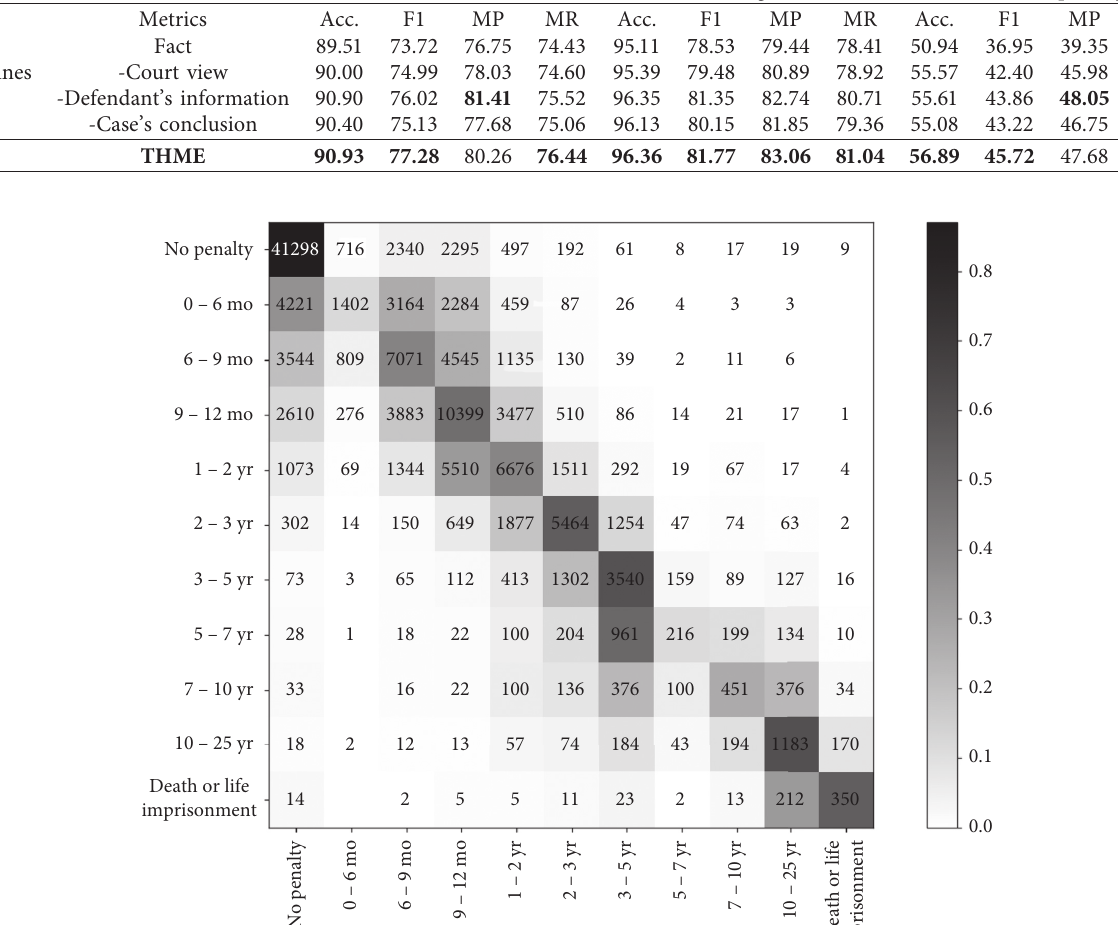
Figure 4: The confusion matrix in the subtask of predicting the terms of penalty. The rows denote the prediction truth while the columns denote the ground truth.